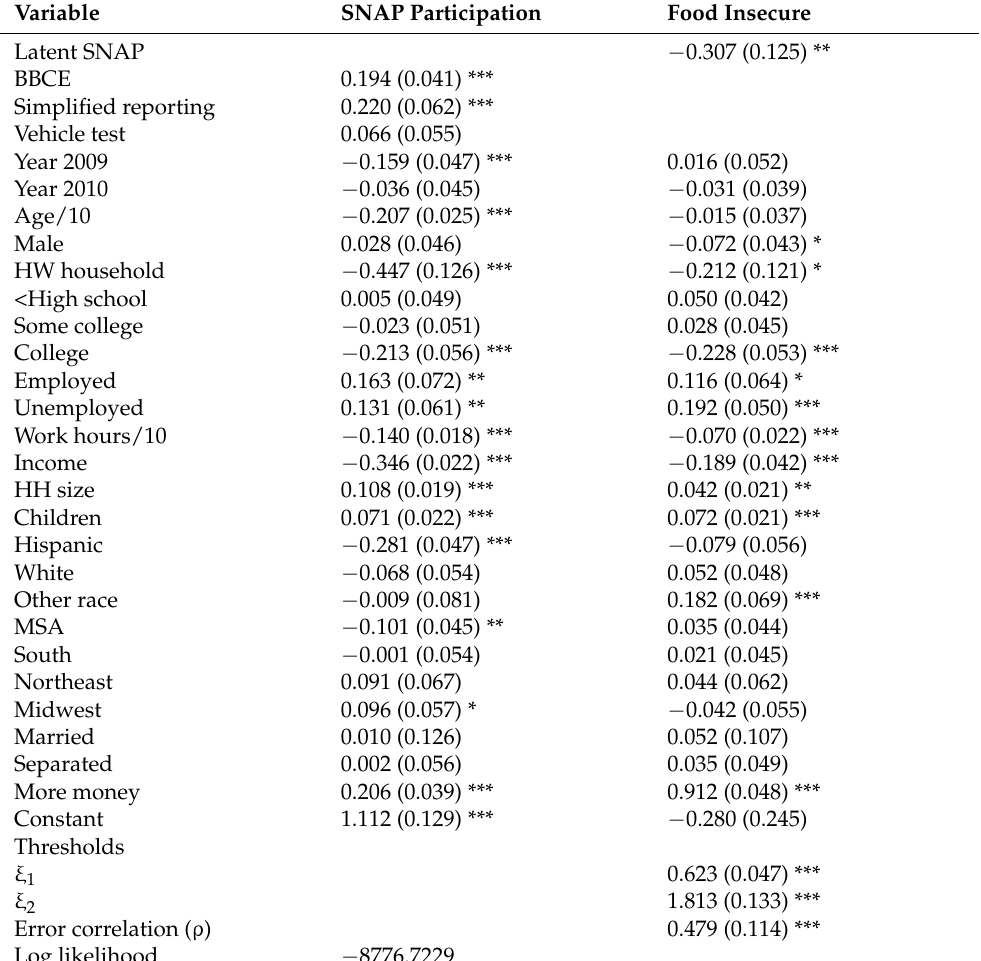
Table A1. Maximum-likelihood estimates of recursive system for SNAP participation and household food